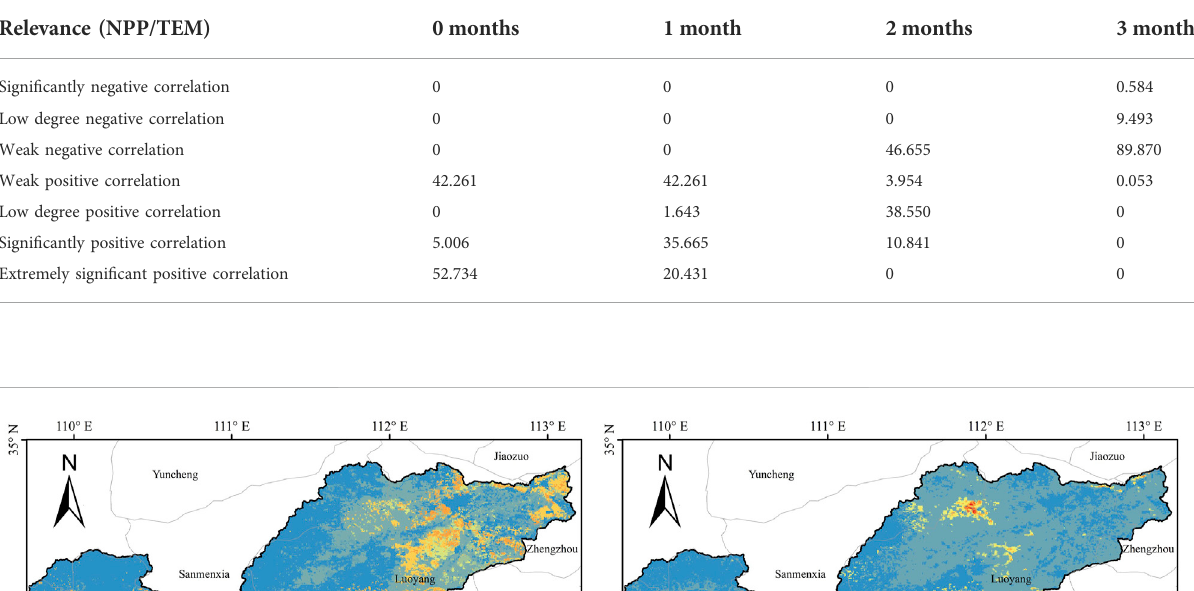
TABLE 4 Proportion of watershed area with different correlation degree between NPP and temperature under different lag time (%).